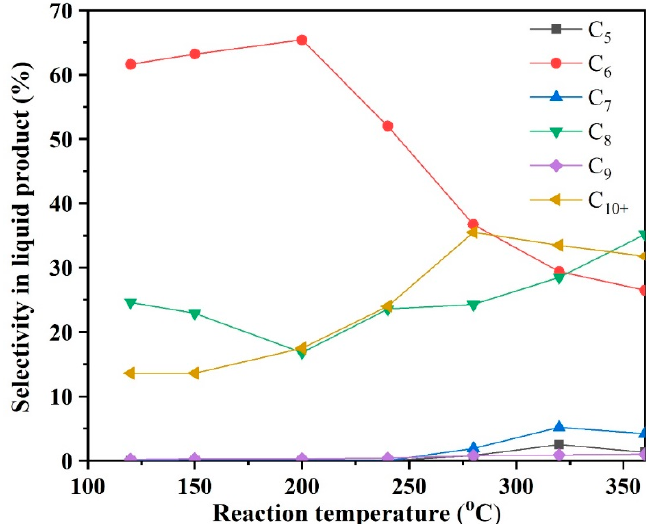
Figure 4. Effect of reaction temperature on the selectivity in the liquid product. Reaction conditions: Si / Al ratio: 25; pressure: 3.5 MPa; WHSV: 2.0 h − 1 ; Ni precursor: Ni(NO 3 ) 2 ; aging temperature: room